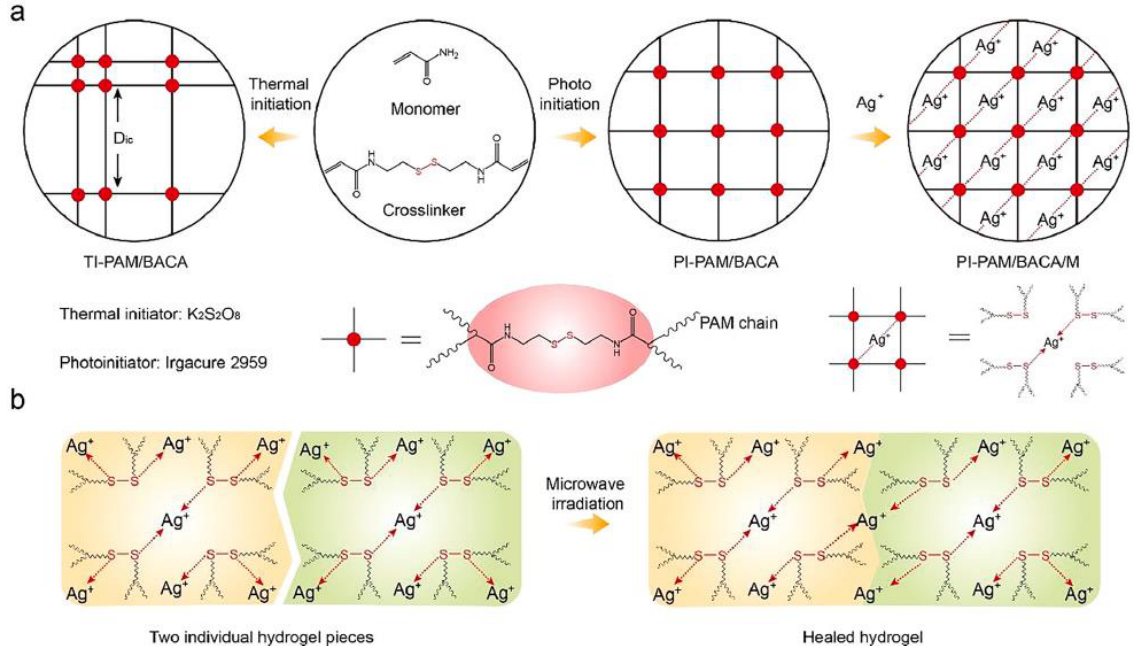
Figure 14 ( a ) Illustrations of the preparation of AM/BACA-based hydrogels using either thermal or photoinduced free-radical polymerization. The introduction of silver cations in the photoinduced network was achieved through a deswelling/swelling process. ( b ) Illustration of the healing mechanism of photoinduced hydrogel under microwave irradiation. Reprinted with permission. Copyright 2021, Elsevier [84].